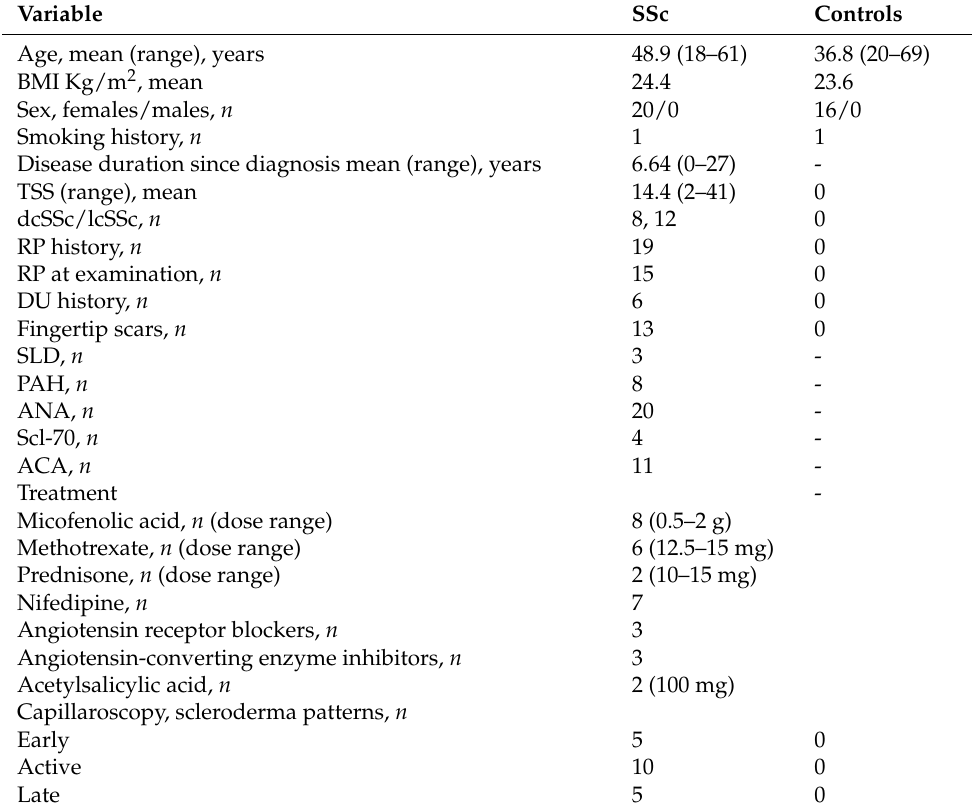
Table 1. Baseline characteristic of SSc group at